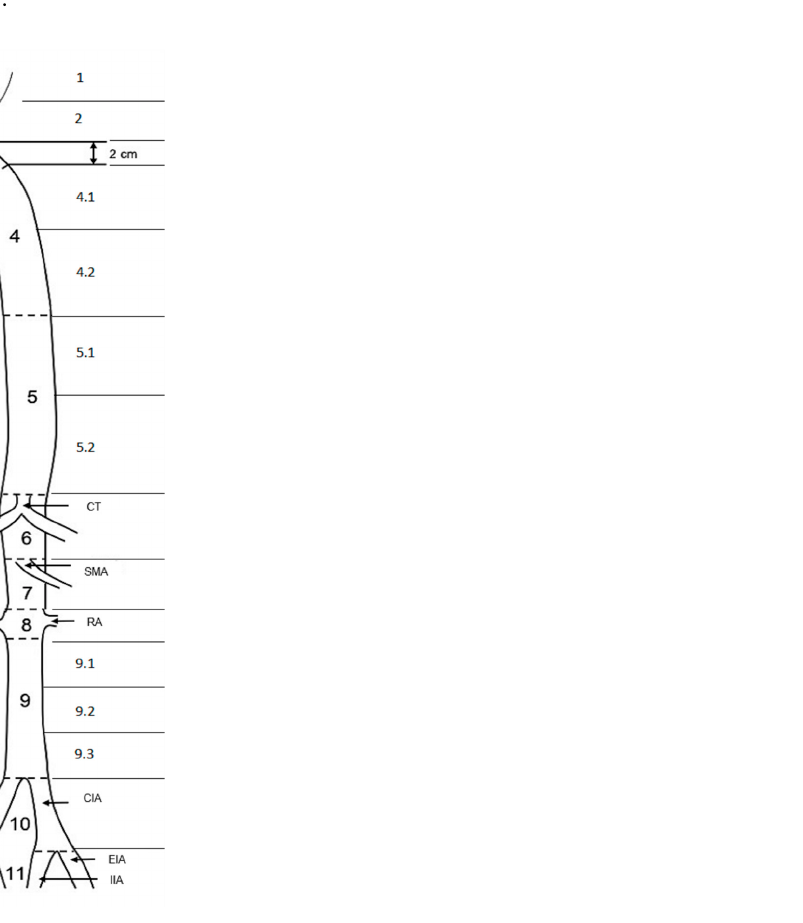
Figure 1. Extended aortic zones; based on Fillinger et al. [12]. CT: celiac trunk; SMA: superior mesenteric artery; RA: renal artery; CIA: common iliac artery; EIA: external iliac artery; IIA: internal iliac artery.